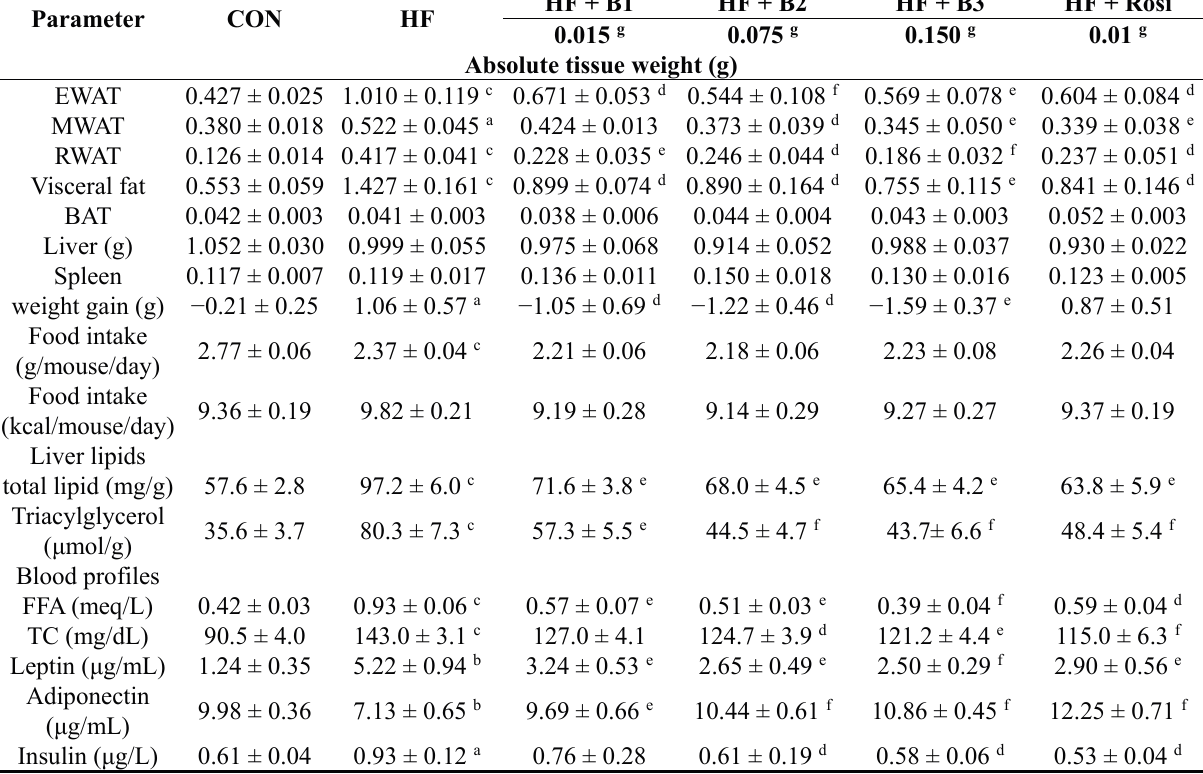
Table 2. Effects of Bofu-tsusho-san (BO) on absolute tissue weight, food intake, liver lipids and blood profiles. All values are means ±S.E. ( n = 9). a p < 0.05, b p < 0.01, c p < 0.001 compared with the control (CON) group; d p < 0.05, e p < 0.01, f p < 0.001 compared with the high-fat + vehicle (distilled water) (HF) group. B1, B2, B3, extract granules of Bofu-tsusho-san (0.015, 0.075 and 0.150 g/kg body weight). BAT, brown adipose tissue; RWAT, retroperioneal white adipose tissue; MWAT, mesenteric white adipose tissue; Visceral fat was defined as the sum of epididymal and retroperioneal WAT; FFA, plasm free fatty acid. g Dose (g/kg/day).